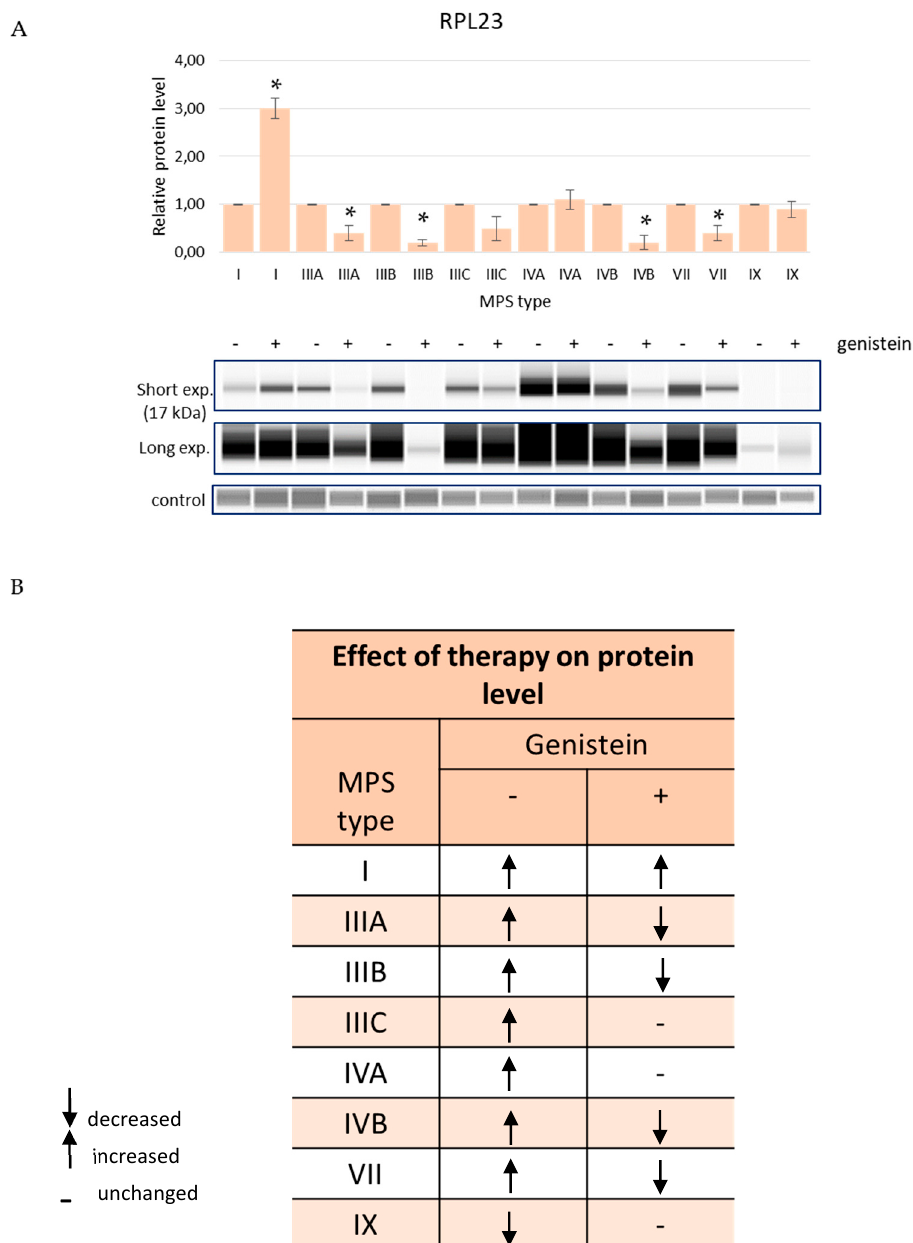
Figure 6. Levels of the RPL23 protein in fibroblasts of different types of MPS with (+) and without ( − ) treatment with 50 μ M genistein for 48 h (only MPS types which revealed significantly changed amounts of this protein relative to HDFa control cells (see Figure 4) are shown). Panel ( A ) shows representative blots and the quantification of the results by densitometry, where value 1 corresponds to the level of RPL23 determined in MPS cells not treated with genistein. Panel ( B ) shows the scheme of results where the column ( − ) indicates the levels of RPL23 in MPS cells relative to HDFa control while the column (+) indicates the levels of this protein in cells of the corresponding MPS types after 48 h of treatment with 50 μ M genistein relative to untreated cells. Up-headed arrows indicate increased levels, down-headed arrows indicate decreased levels, and dashes indicate no significant changes. In panel ( A ), the results indicated by columns are mean values from three independent experiments with error bars representing SD. Statistically significant differences relative to the untreated MPS cells ( p < 0.05) are indicated by asterisks (*).